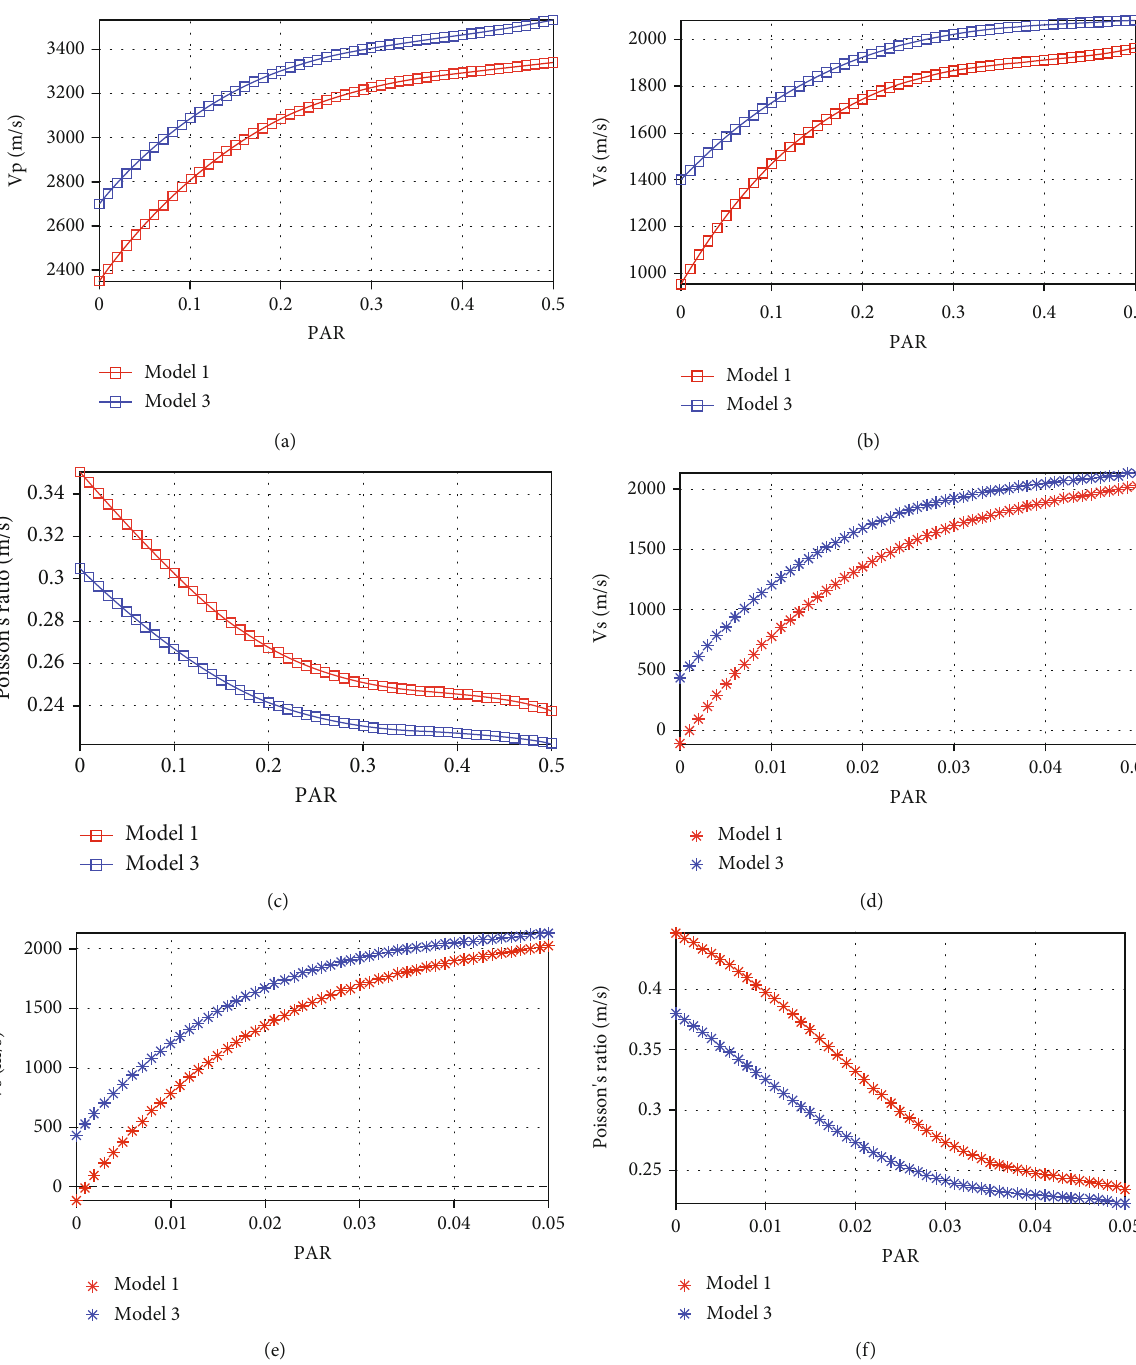
and PAR of s and PAR of penny- p